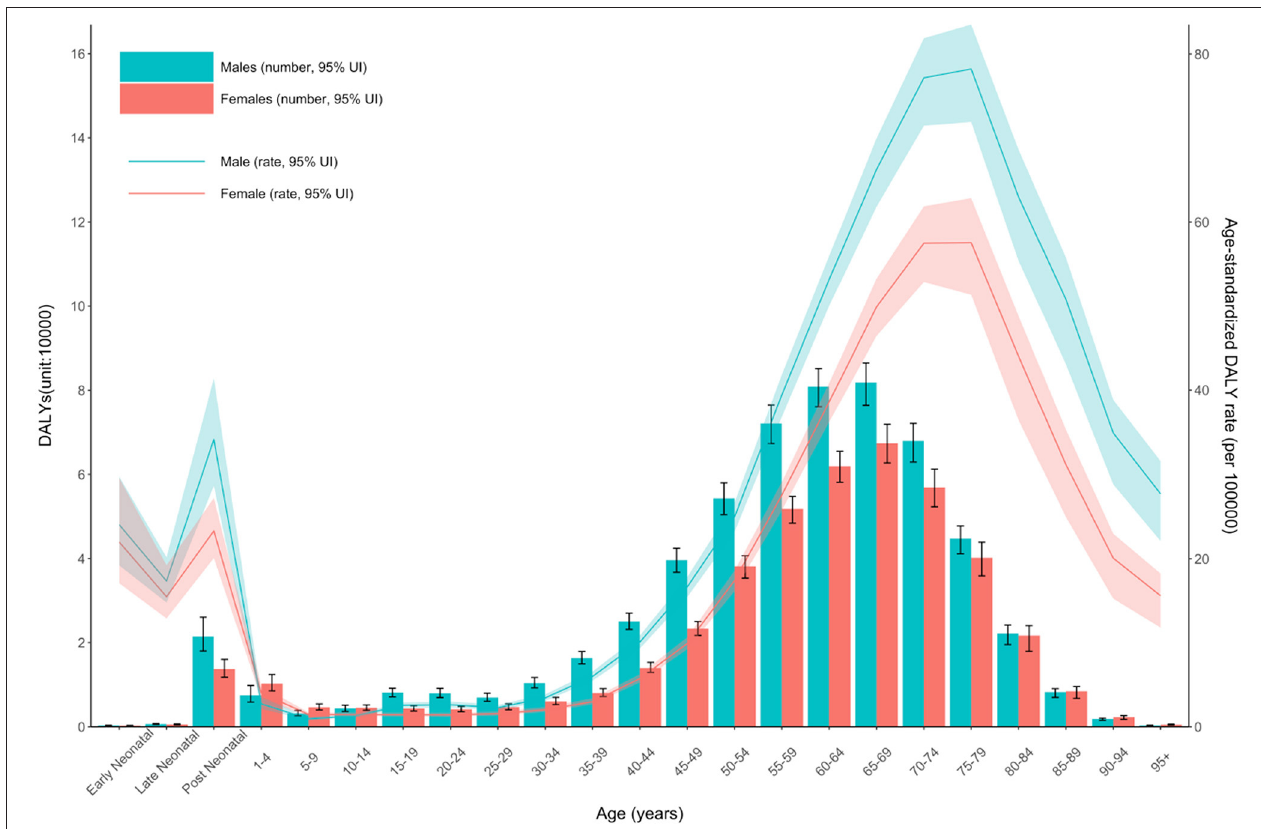
FIGURE 4 | Age-standardized DALY rate of motor neuron diseases by Global Burden of Disease regions by sociodemographic index, 1990–2019. Age-standardized DALY rates are presented as rates per 100,000 population. DALY, disability-adjusted life-years; SDI, sociodemographic